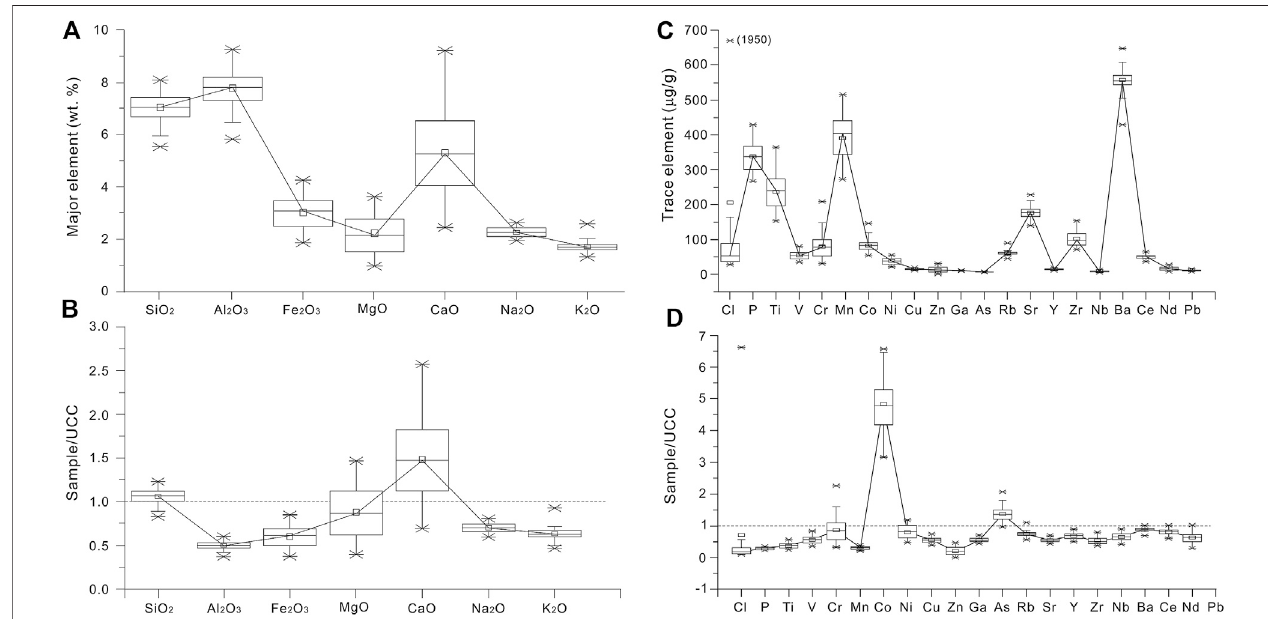
FIGURE 7 | Compositions of the major and trace elements and their UCC-standardized distributions of sand dunes in the Jinta-Gaotai area of the middle Hexi Corridor (modi fi ed after Zhang et al. (2020)).